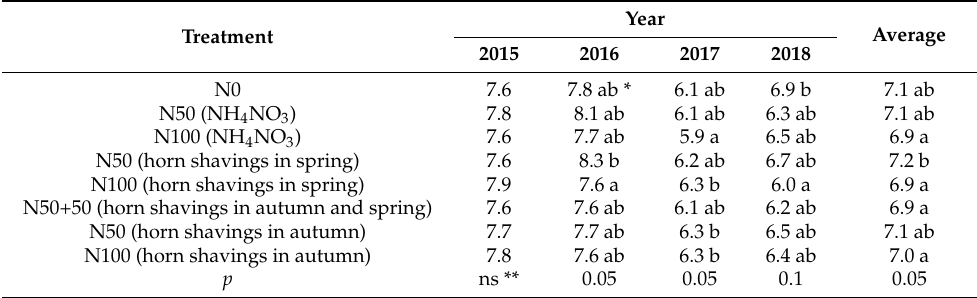
Table 7. Fertiliser effect on Ligol apple flesh firmness (kg/cm 2 ).